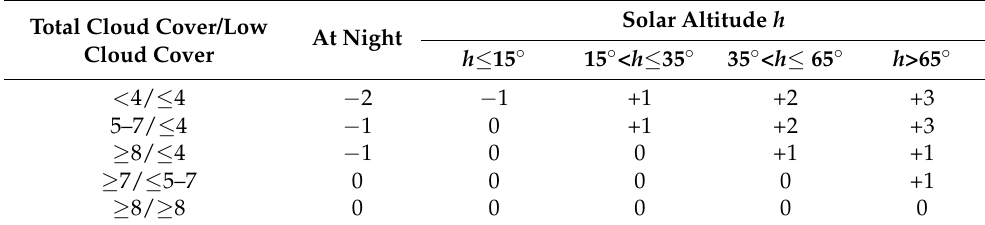
Table 3. Determination of intensity of solar